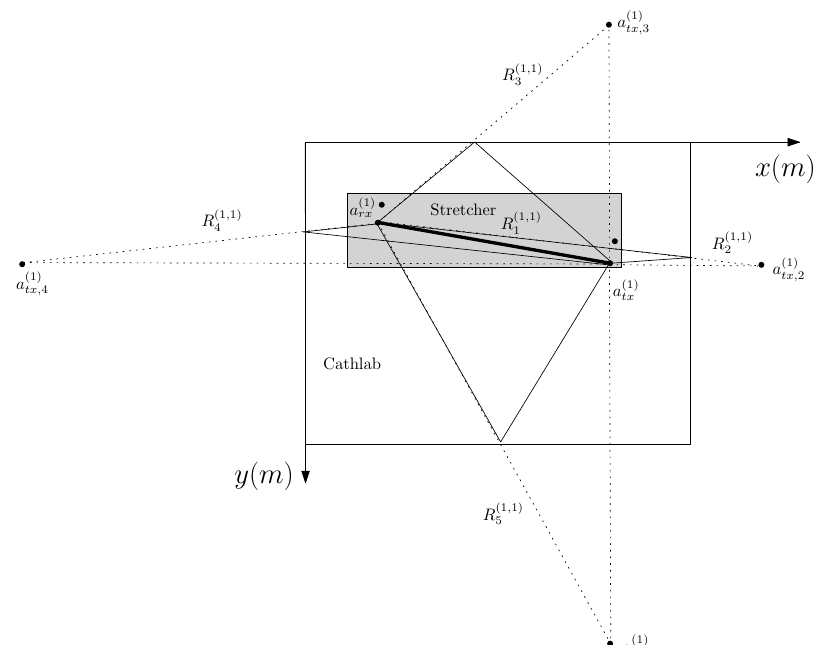
Figure 4. Example of the images method applied to the CathLab environment considering a MIMO system with M = 2 and N =